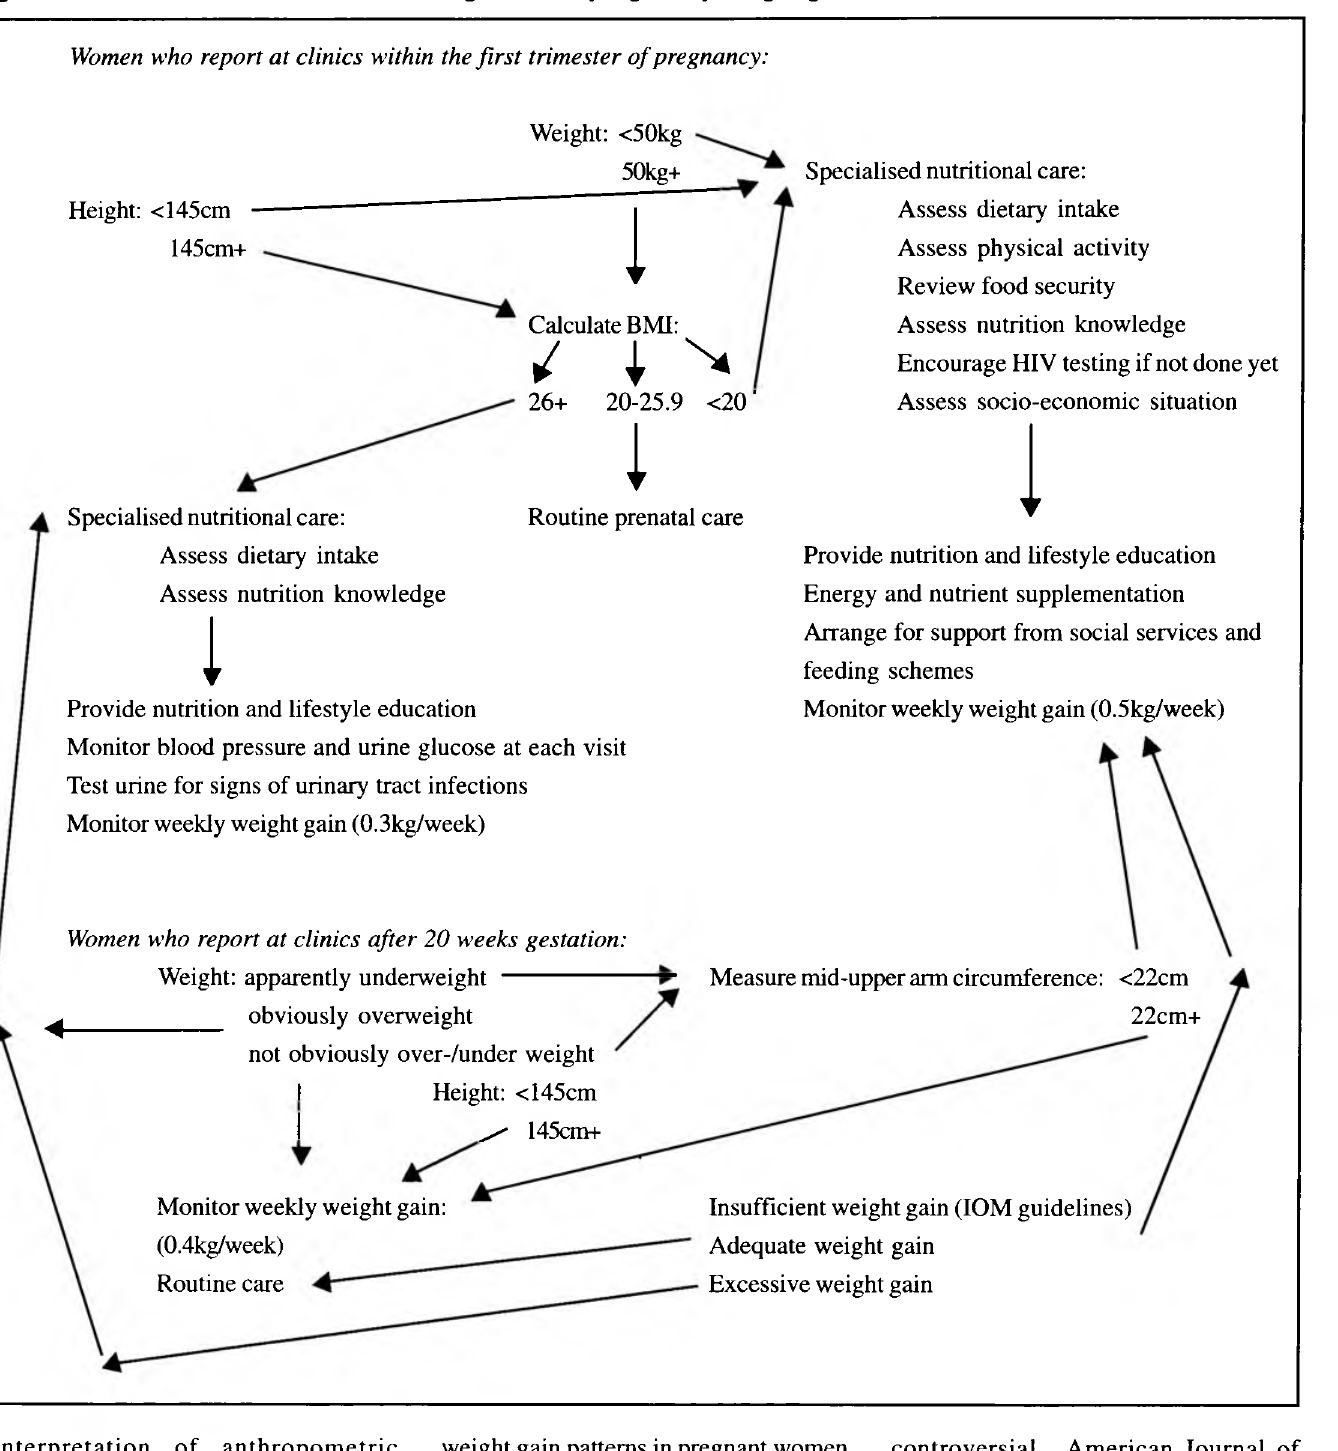
Figure 1 A framework for the management of pregnancy weight